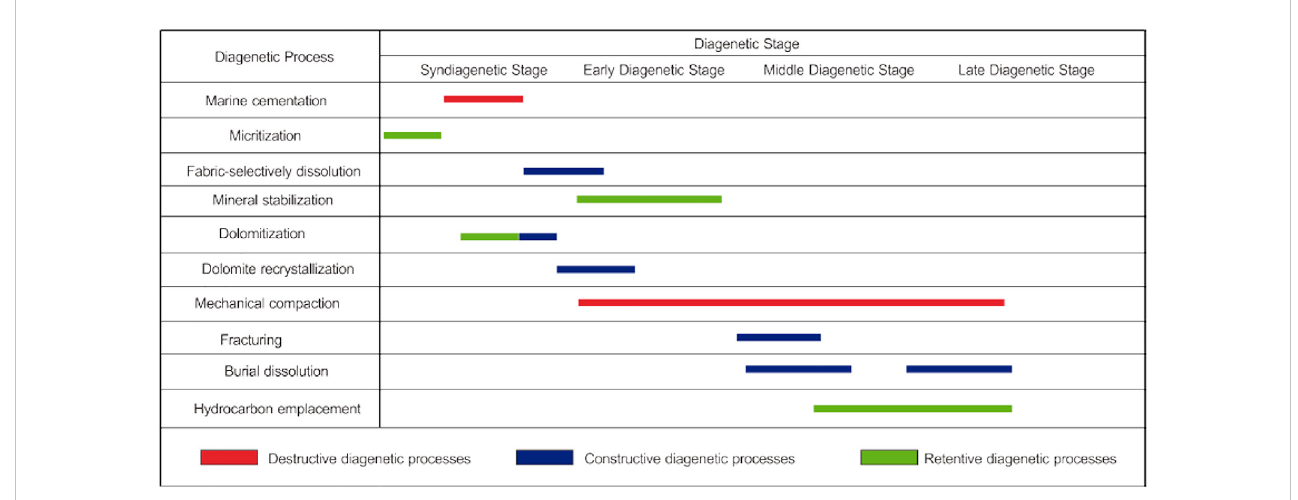
FIGURE 11 Paragenetic sequence of the diagenetic processes in Feixianguan Formation tight oolitic reservoir.